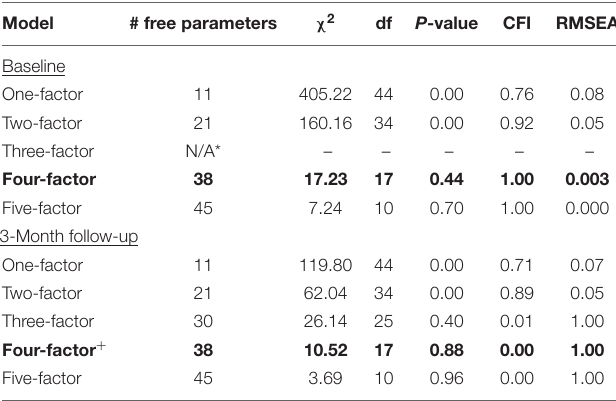
TABLE 2 | Model fit indices for exploratory factor analyses of perceived challenges at baseline ( N = 1,257) and 3-month follow-up ( N = 320).